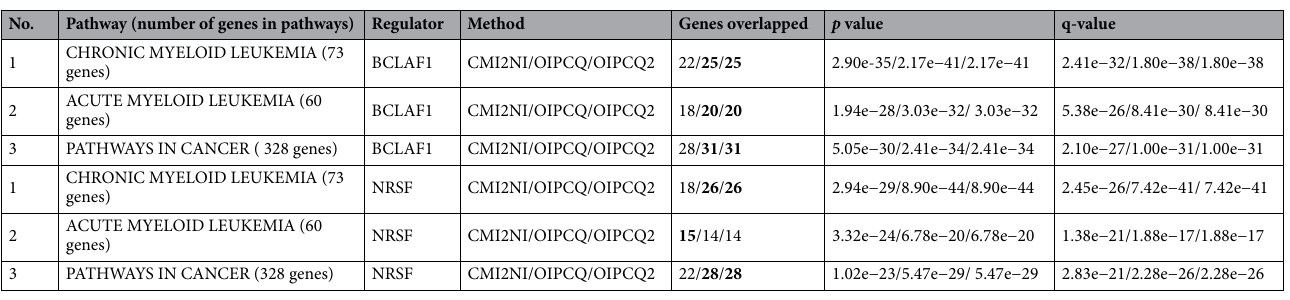
Table 5. Comparison of CMI2NI, OIPCQ and OIPCQ2 methods based on the three important pathways resulted by KEGG. Best results are indicated in bold. Among the significant pathways, three most significant ones were selected. The pathway enrichment was done separately for each of the four regulators ZBTB7A, PU1, BCLAF1 and NRSF. Column 1 indicates the name of pathways and number of genes in pathways. The name of regulators and algorithms are in columns 2 and 3, respectively. The overlap between resulted sets and genes in pathways are represented in columns 4. The related p values and q-values are collected in columns 5 and 6, respectively.